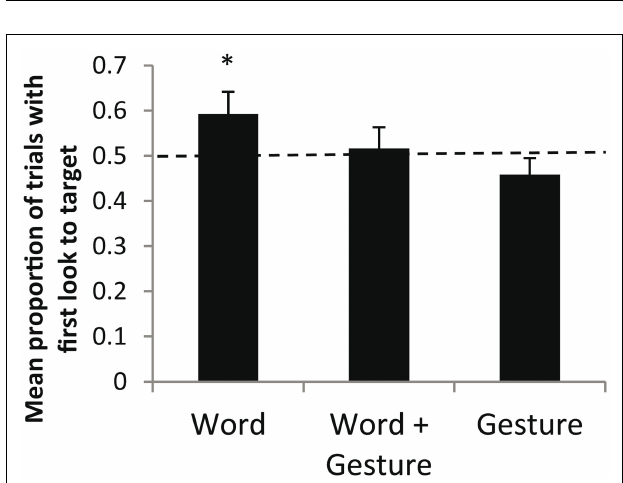
FIGURE 3 | Proportion of trials with the first look to the target object. Note: Asterisk indicates significant performance above chance, p < 0.05.